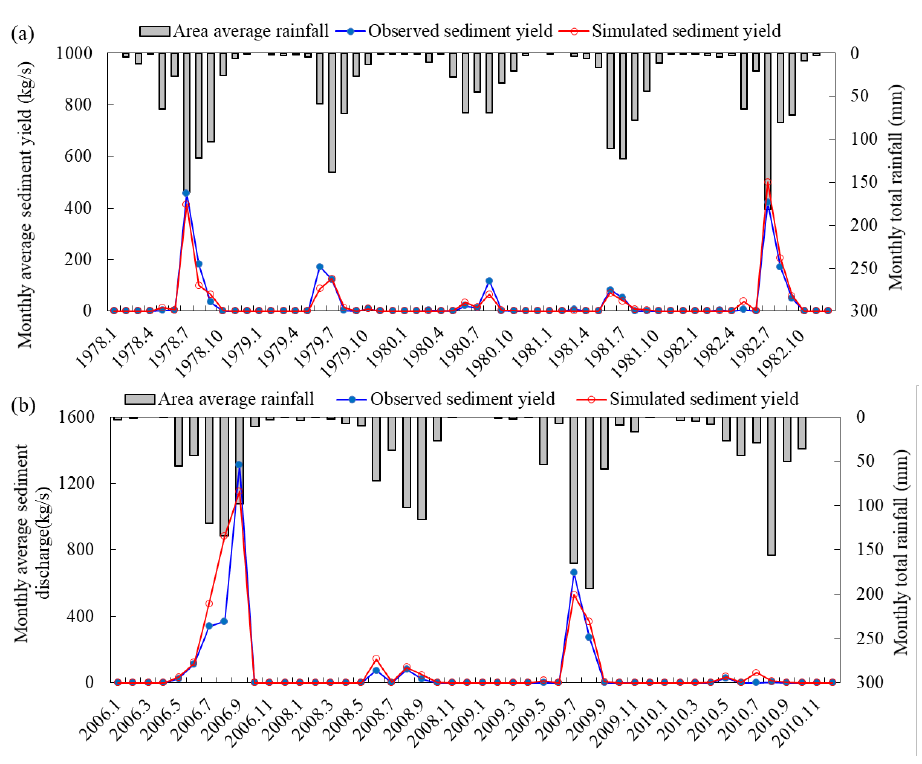
Figure 5. The observed and simulated monthly average sediment discharges in the 1980s ( a ) and 2010s ( b ).